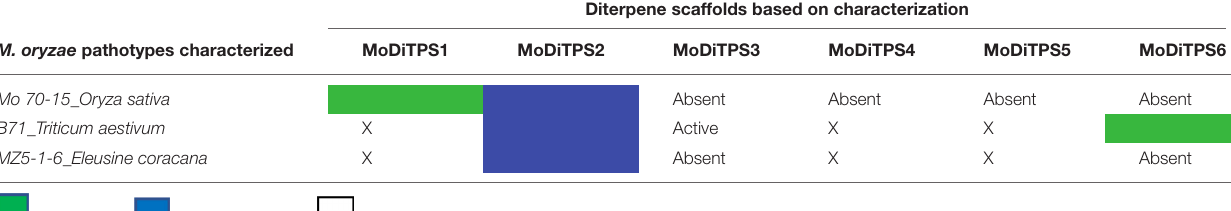
Diterpene scaffolds based on